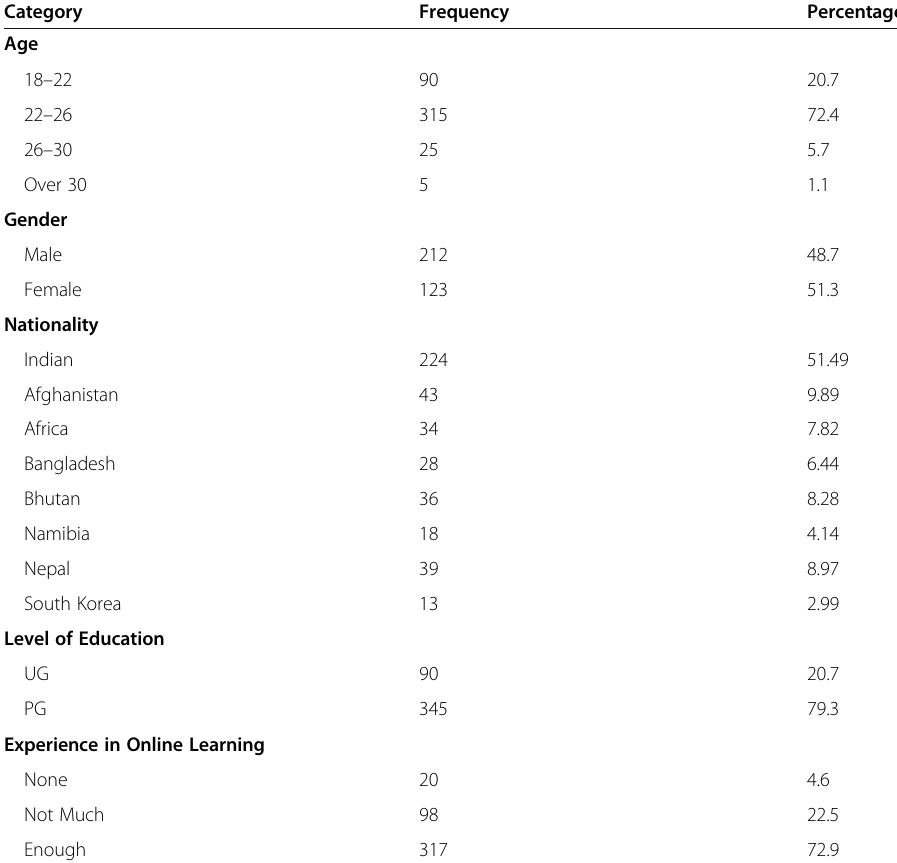
Table 1 Demographic profile of